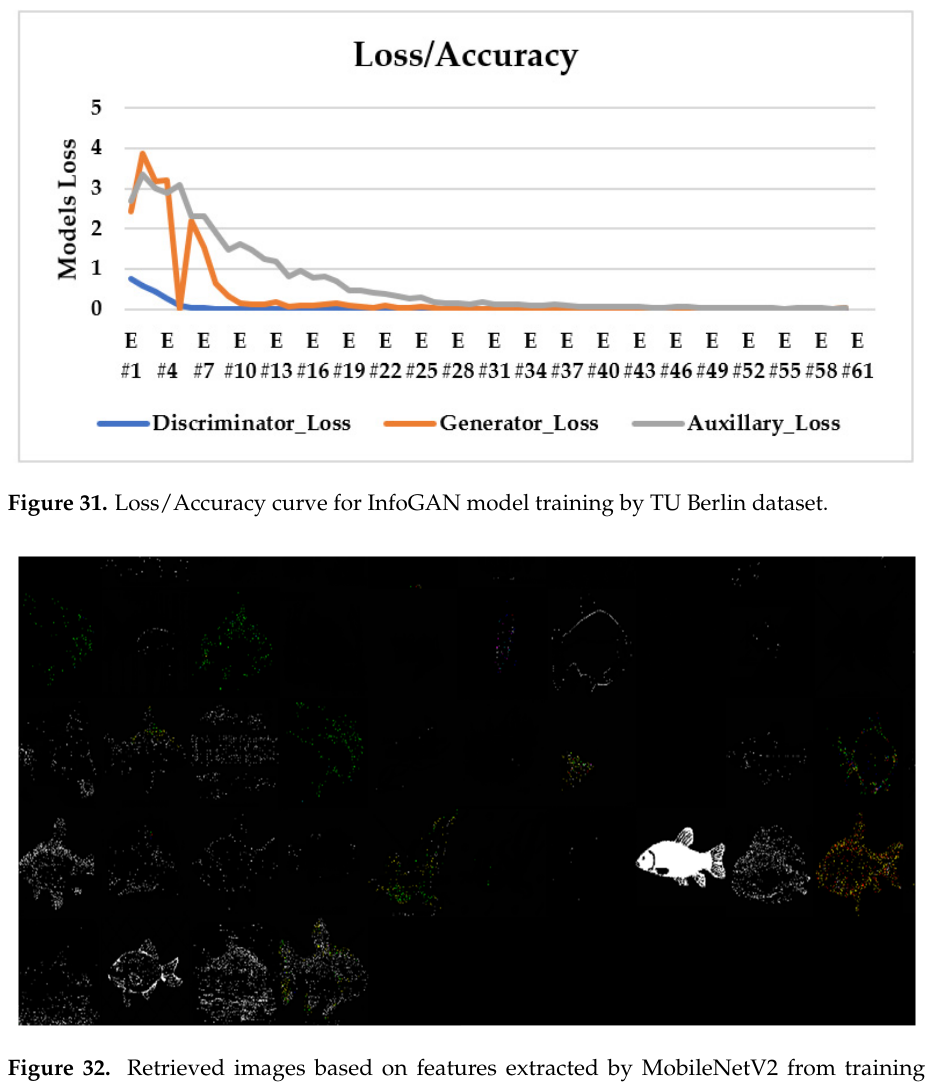
Figure 31. Loss/Accuracy curve for InfoGAN model training by TU Berlin dataset.